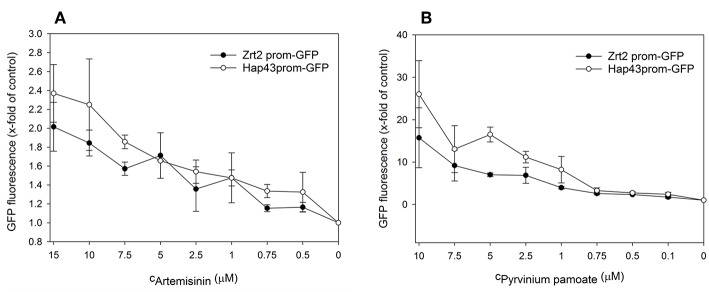
A culture of the promoter-reporter strains of Candida albicans were adjusted to a cell density OD600 = 0.05 and grown in RPMI, pH 7.2 at 37°C for 16 h with indicated concentrations of (A) Artemisinin or (B) Pyrvinium pamoate when cell density (OD600) and GFP fluorescence was measured. The values are the means ± standard deviation (SD) of at least 3 independent experiments.